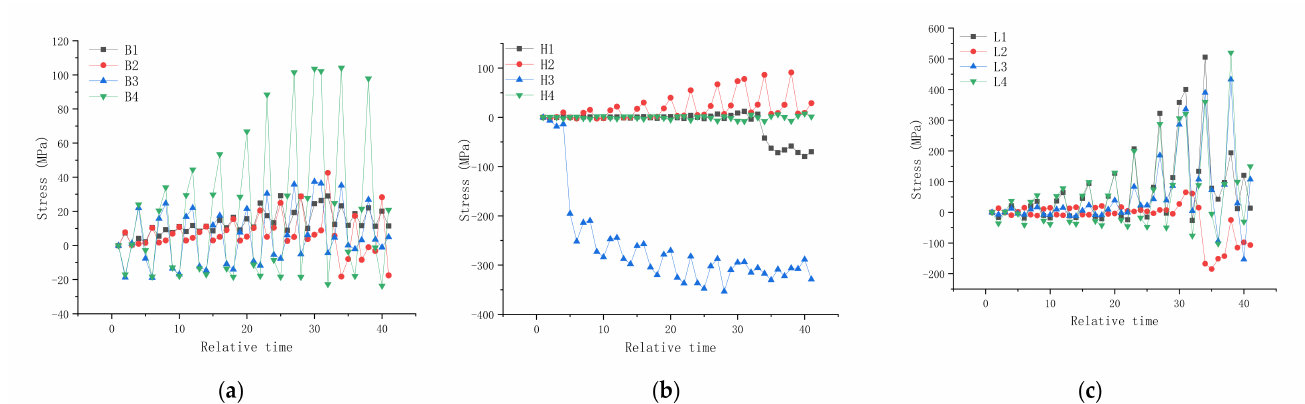
Figure 15. Stress changes with loading cycles (B1 − 4, H1 − 4 and L1 − 4 are sensors as shown in Figure 11). ( a ) Stress change in steel plate; ( b ) stress change in steel section; ( c ) stress change in steel bar.